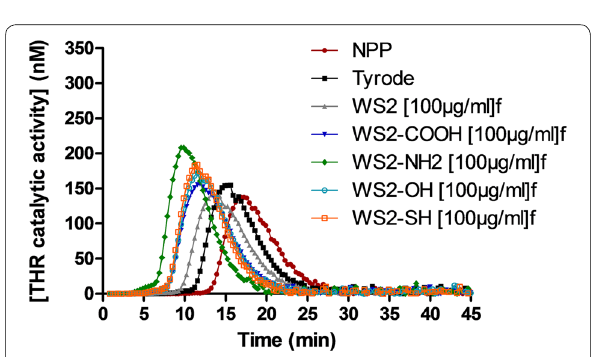
Fig. 4 Thrombin activity profiles in the presence of INTs‑WS 2 / f ‑INTs‑WS 2 at 100 µg/mL. Data represent the mean of three independent